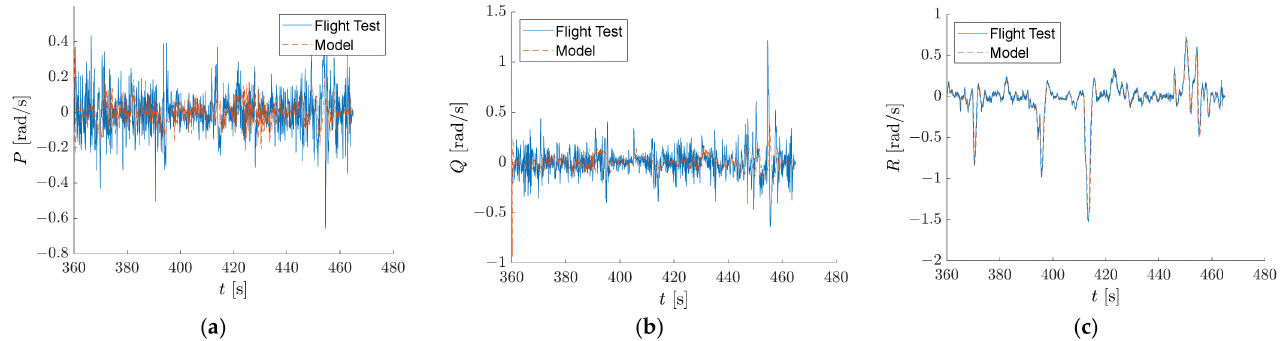
Figure 12. Angular rates: ( a ) roll, ( b ) pitch, and ( c ) yaw.